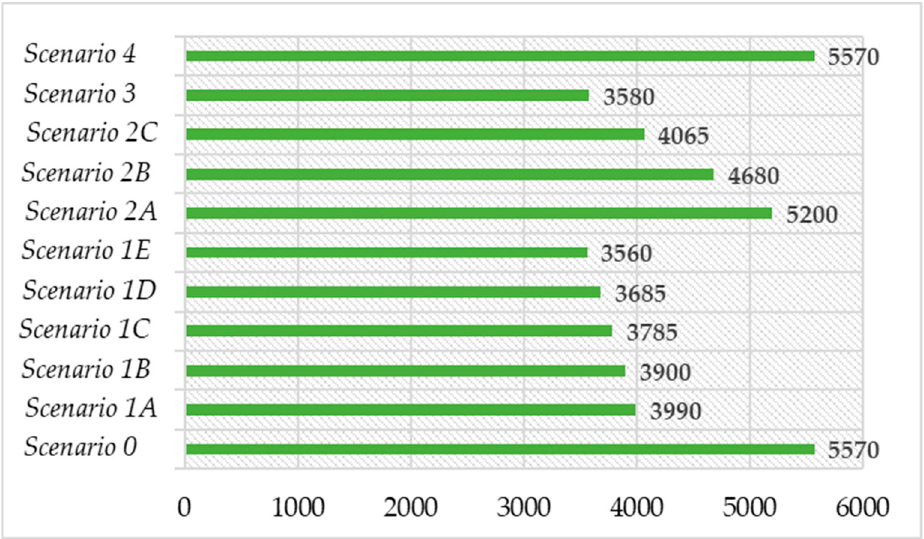
Figure 4. Heating demand of the building depending on the adopted scenario.